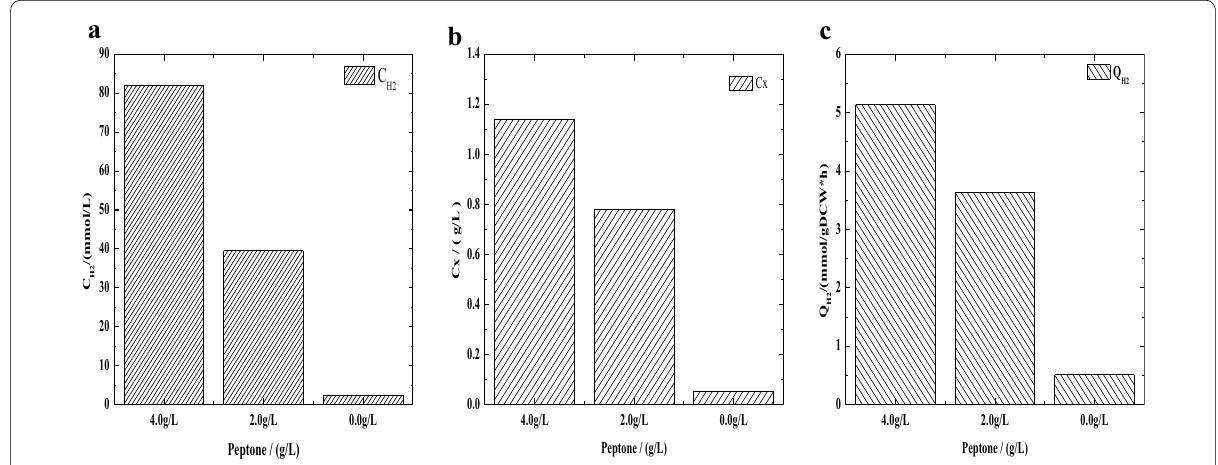
Fig. 12 The effect of nitrogen source on C H2 \ C x \ Q H2 by EB-06 glycerol